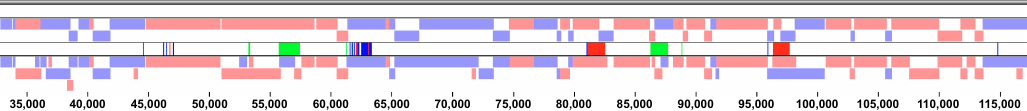
Figure 3. Visual summary from BBB. Pink and pale blue boxes represent genes transcribed to the right and left, respectively, for the genomes of two poxviruses. The centre tract indicates differences between the two sequences: Dark blue lines are SNPs (the abruptly dense SNPs turns out to be falsely assembled out-of-frame sequence from another virus) and green and red blocks show insertions and deletions (erroneously transposed sequences).